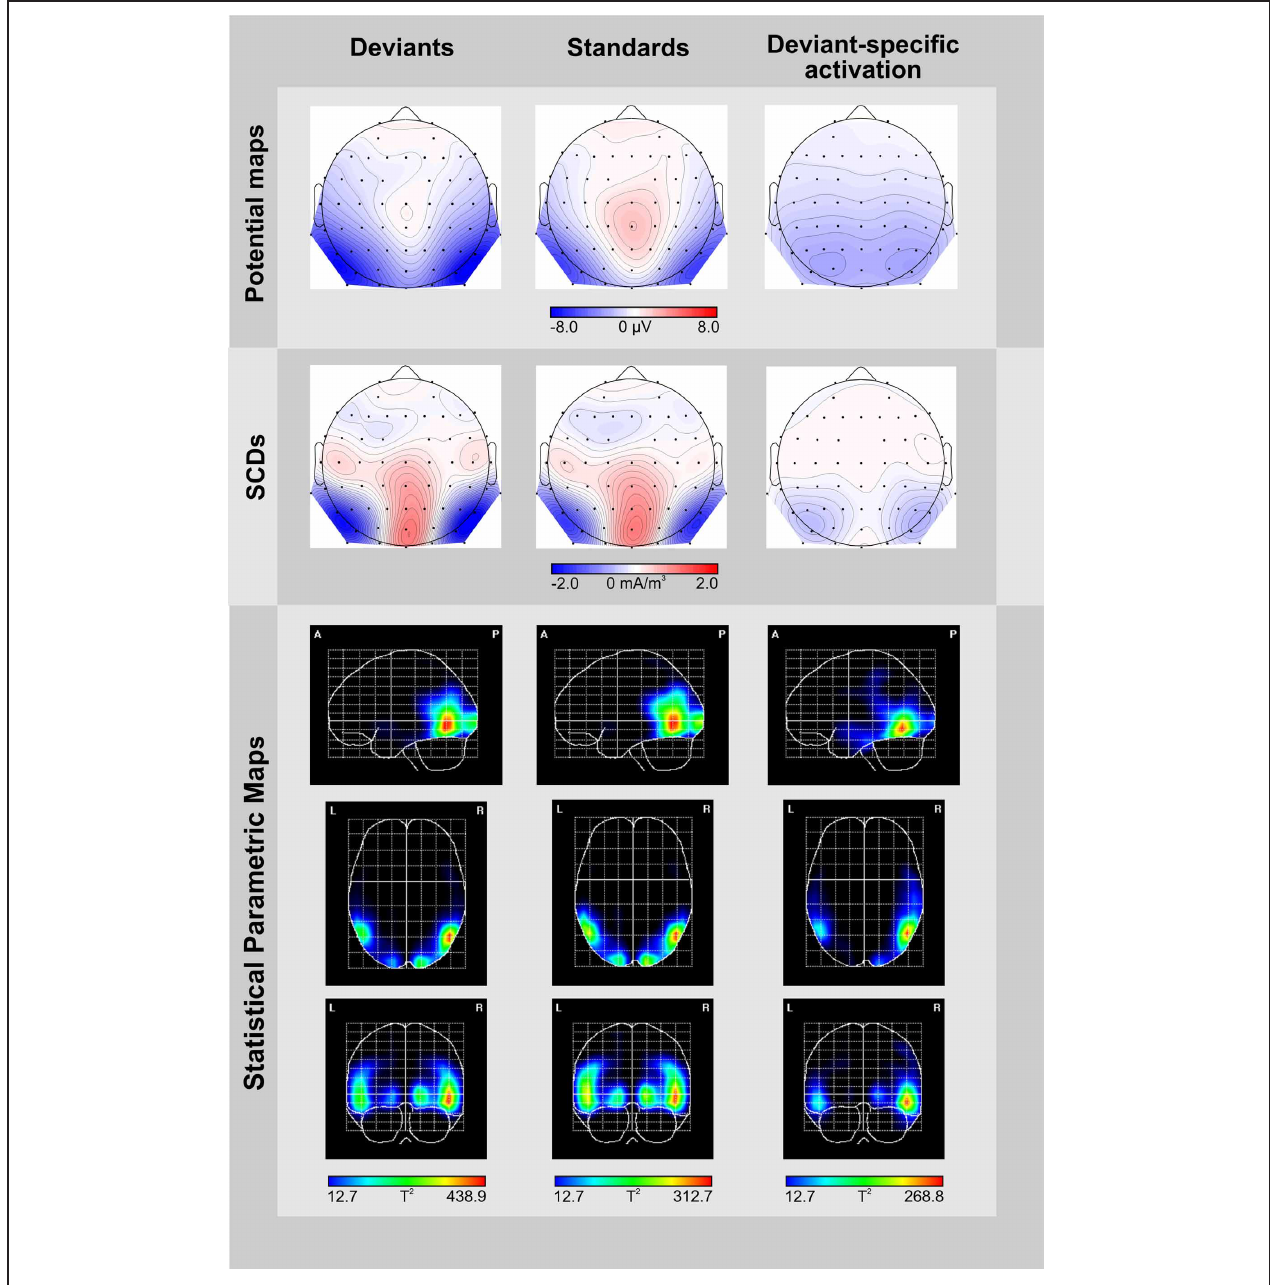
deviant-minus-standard difference waves. A smoothing parameter of lambda = 10 − 5 was applied to the SCDs. Source localizations computed by VARETA are displayed as statistical parametric maps (third row), thus illustrating the probability of activation within cortical regions (threshold T 2 > 12 . 7 corresponds to a Bonferroni-corrected p < 0 . 0001). Deviant-specific source localization is displayed as the contrast between the solutions obtained for deviants vs.